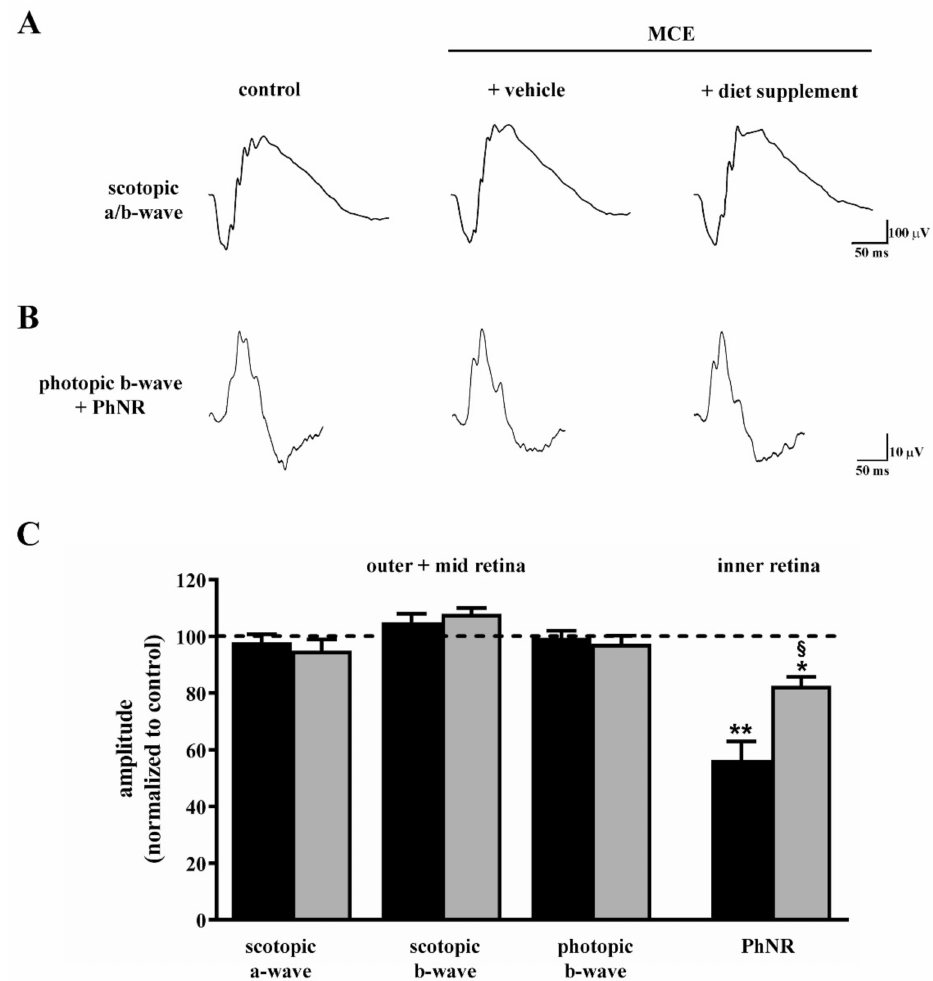
Figure 2. E ff ects of dietary supplementation on retinal function as evaluated by scotopic and photopic full-field electroretinogram (ERG). Representative ERG traces showing scotopic a- and b-waves ( A ) or photopic b-waves with photopic negative response (PhNR; ( B )) in control mice and in mice that received intraocular MCE injection fed with either vehicle or diet supplement. ( C ) Mean amplitudes of ERG responses evaluated as changes from baseline, normalized to the amplitude measured in control mice. MCE did not a ff ect the amplitude of the scotopic a-wave, scotopic b-wave and photopic b-wave, while it reduced the amplitude of PhNR. Dietary supplementation partially prevented the reduction in PhNR amplitude. Data are shown as mean ± SEM ( n = 6 for each group). * p < 0.01 and ** p < 0.001 versus control; § p < 0.001 versus MCE mice fed with vehicle (one-way ANOVA followed by the Newman–Keuls multiple comparison post-hoc test). Black bars: mice intraocularly injected with MCE fed with vehicle; grey bars: mice intraocularly injected with MCE fed with diet